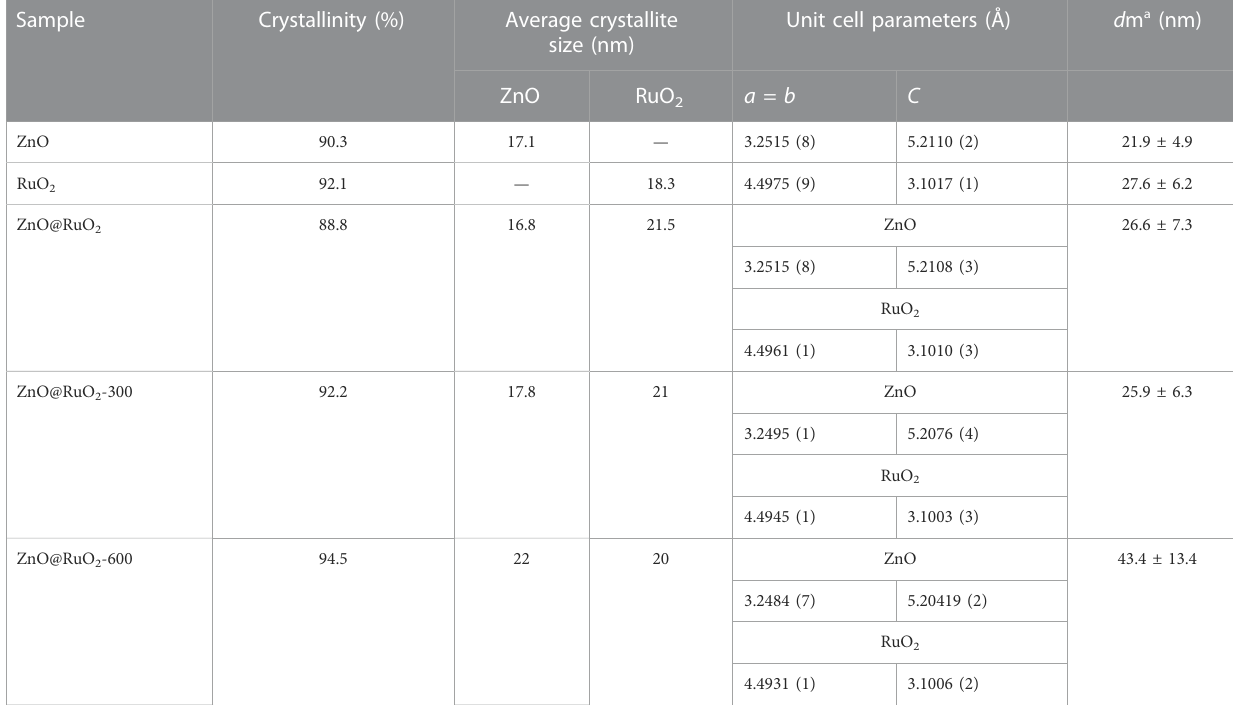
(LO) modes in the Raman spectrum of pristine ZnO (Figure 4) suggest a certain amount of intrinsic bulk defects caused by rapid crystallization driven by microwave irradiation (Markovi ć et al., 2019; Raji ć et al., 2020). The phonon modes observed in the Raman spectrum of pure ZnO were typical of wurtzite ZnO with a space group of C 4 (Pimentel et al., 2014). Three major features in the 6 v Raman spectrum of bare RuO 2 , the, E g, A 1g , and B 2g modes, are located at 528, 646, and 716 cm – 1 , respectively (Chen et al., 2004). All the peaks in the Raman spectra of the 10ZnO@1RuO 2 composites could be attributed to ZnO and RuO 2 , with no peaks related to impurities. The disappearance of the 2LA Raman mode with composite annealing suggested the disappearance of surface defects, while the more intense and narrower E 2H band indicates increased crystallinity with more ordered local symmetry. A slight blue shift in the Raman peak positions and line narrowing of the RuO 2 particles in the annealed composites relative to those of the as- prepared 10ZnO@1RuO 2 indicate increased crystallinity and particle size. morphology of the ZnO, RuO 2 , and 10ZnO@1RuO 2 particles,